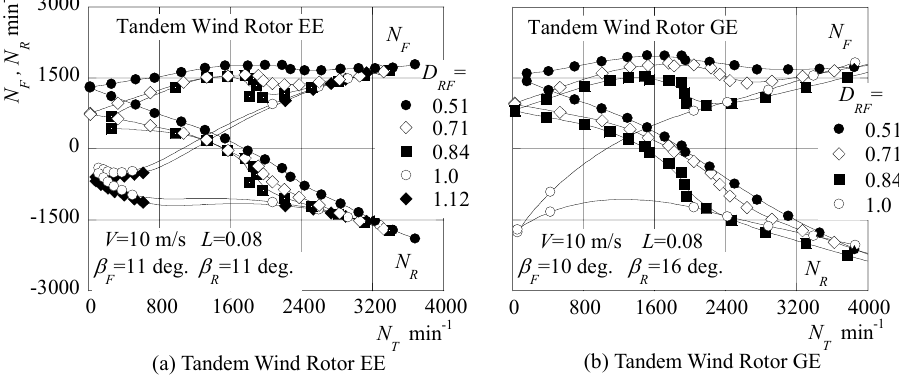
Fig.7 Rotational behaviors of the tandem wind rotors